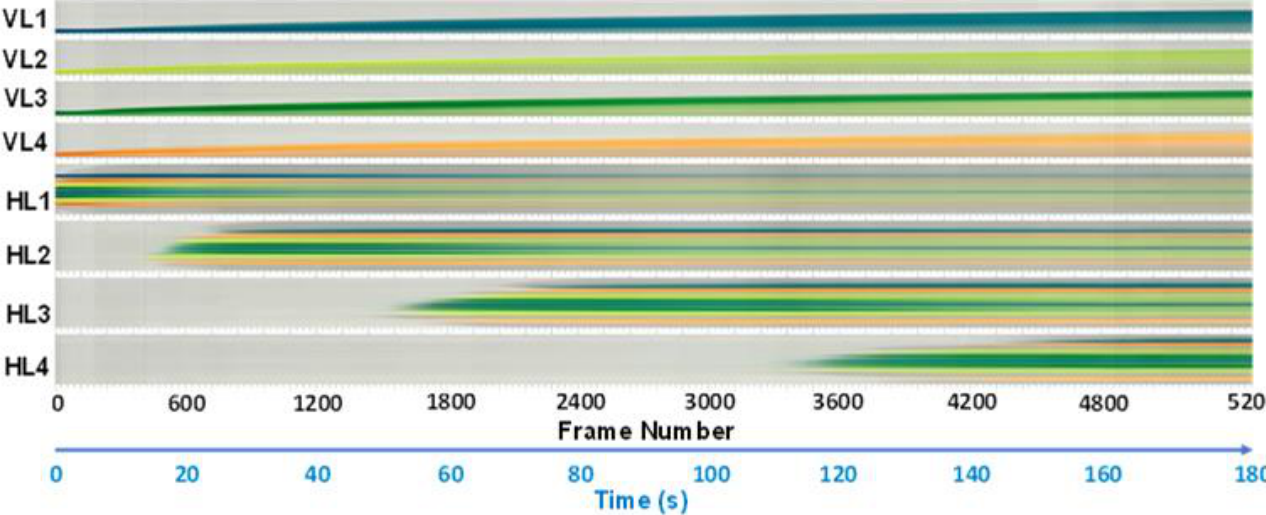
Figure 5. Time cross-section operation of four vertically sloped line segments (VL1~VL4) and four horizontal line segments (HL1~HL4) from entire frames of images for information extraction using PicMan.